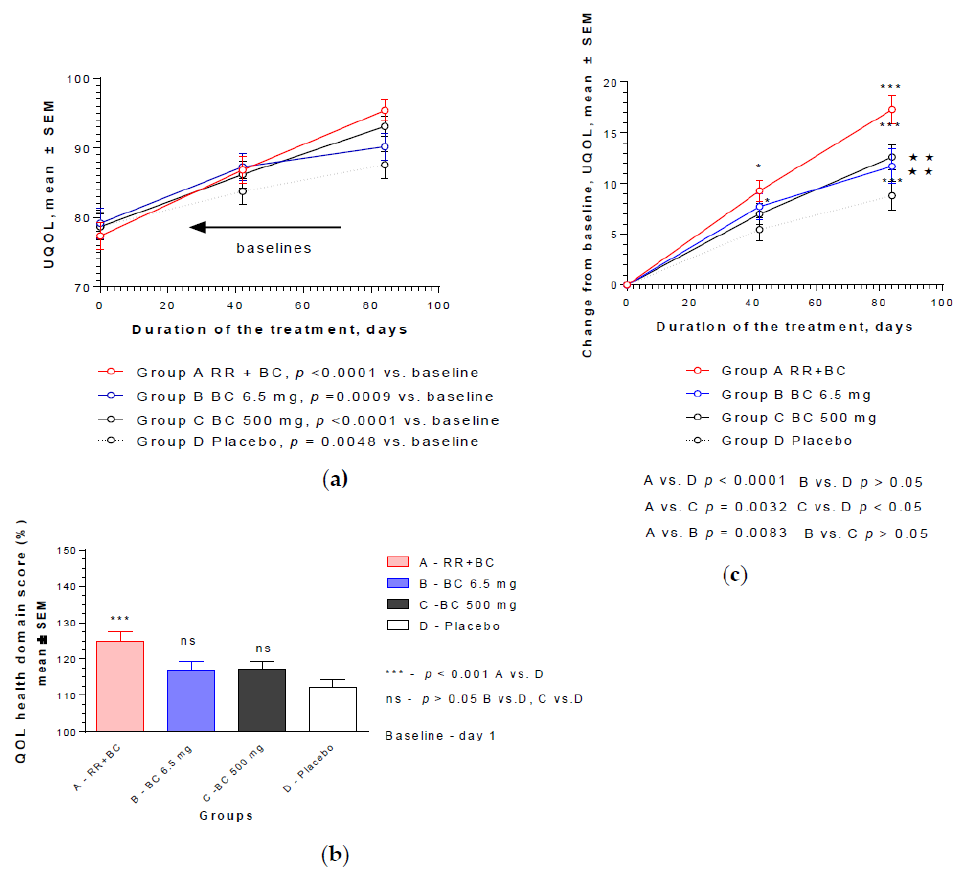
Figure 4. Effects of RR-BC (Group A), BC (Group B), BC500 (Group C), and placebo (Group D) on overall quality of life after 12 weeks (84 days) of treatment, as assessed by the UQOL scale: ( a ) significant increase of UQOL (mean ± SEM) score compared to baseline values was observed in all groups over time ( p < 0.01; p < 0.001); ( b ) significant difference in UQOL (% to baseline, 100%, mean ± SEM) was observed in group A compared to placebo group at the end of the treatment—Day 84, ( p < 0.0001), but not groups B or C vs. placebo; ( c ) statistically significant interaction effects between treatment groups and response (change from the baseline of UQOL, mean ± SEM) over time showed significant difference between groups A, B, and C vs. placebo, as well as group A vs. groups B and C ( p = 0.0083 and p = 0.032) but not between the two BC groups, B and C (two-way ANOVA). Significance of difference between groups at various time points, calculated by Bonferroni post-test, is expressed by symbols * p < 0.05, *** p < 0.001; ns: not significant (A, B, C vs. placebo) and ** p < 0.01 (B and C vs. A).